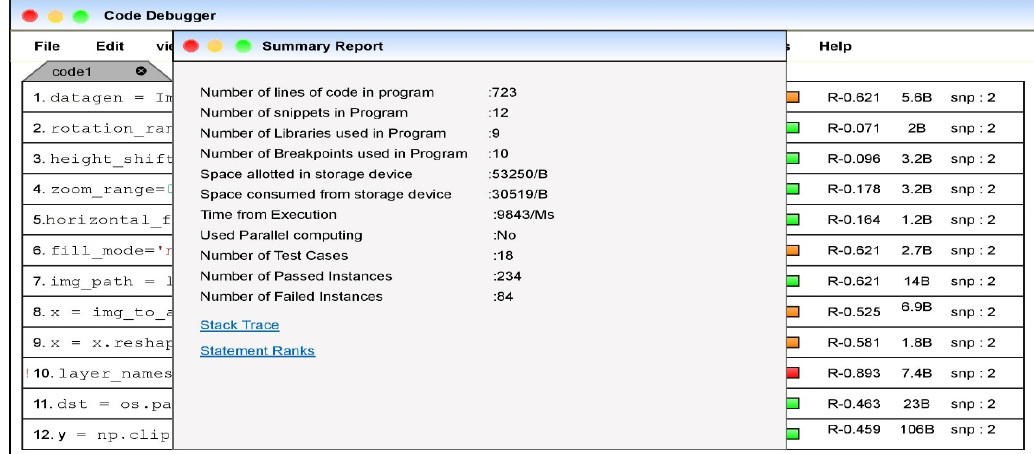
Figure 10. Image summarized report about the code snippet.